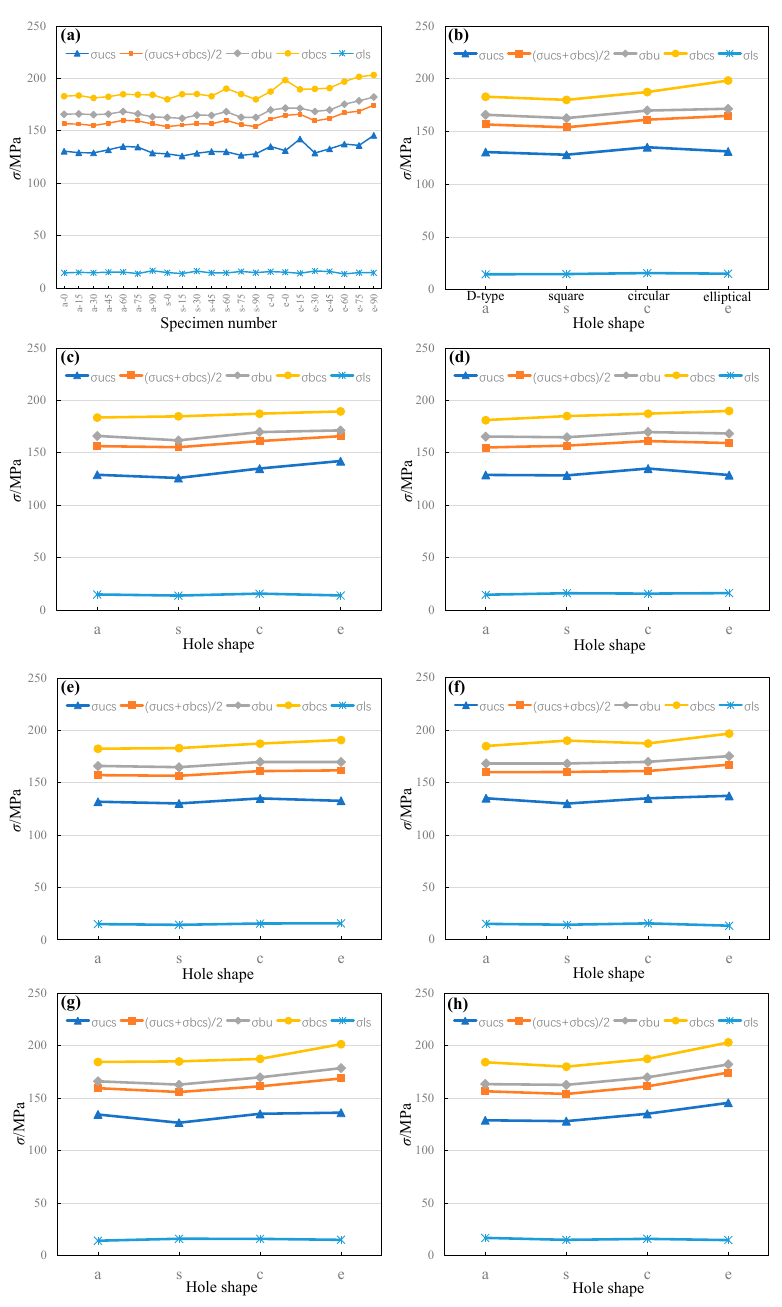
Figure 6. Change curves of peak stresses at rock failure, including ( a ) changes in uniaxial compression strength ( σ ucs ), biaxial compressive strength ( σ bcs ), peak biaxial unloading strength ( σ bu ), and the corresponding peak biaxial unloading lateral stress ( σ ls ) for all specimens, and the peak stresses for specimens with ( b ) 0°, ( c ) 15°, ( d ) 30°, ( e ) 45°, ( f ) 60°, ( g ) 75°, and ( h ) 90° inclination angles.